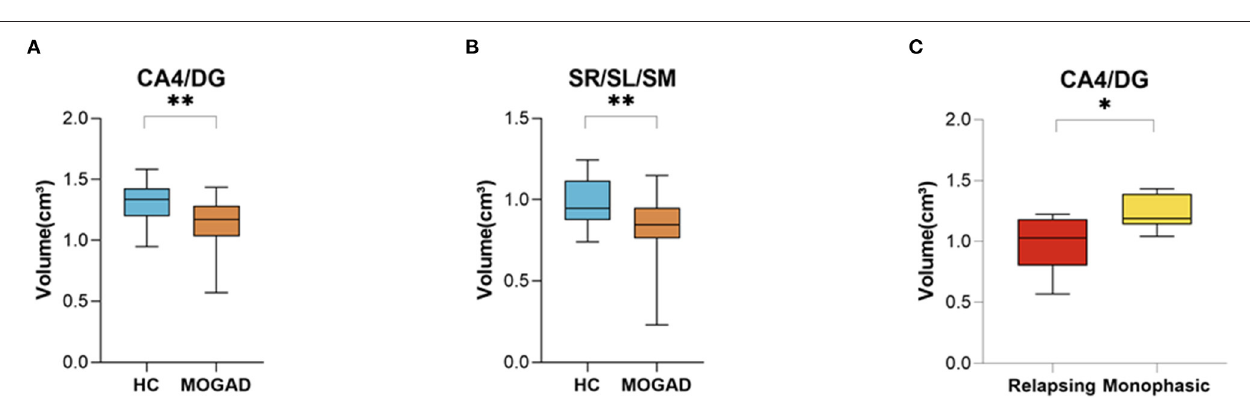
FIGURE 6 | Decreased Volume of CA4/DG at MOGAD patients compare to HCs. (A,B) Volume of hippocampal subfields of HCs ( n = 21) and MOGAD patients ( n = 18) analyzed by HIPS pipeline of Volbrain software. (A) Volumes of CA/DG4 (1.31 ± 0.18 vs. 1.14 ± 0.21, p = 0.009) and (B) SR/SL/SM (0.98 ± 0.14 vs. 0.82 ± 0.22, p = 0.008). (C) Volume of hippocampal subfields of monophasic ( n = 6) and relapsing patients ( n = 6), analyzed by HIPS pipeline of Volbrain software. (C) CA4/DG (0.98 ± 0.24 vs. 1.23 ± 0.14, p = 0.03) volume of MOGAD monophasic and relapsing course patients. MOGAD, Myelin oligodendrocyte glycoprotein antibody disorders; HCs, healthy controls. p * ≤ 0.05, ** ≤ 0.01.